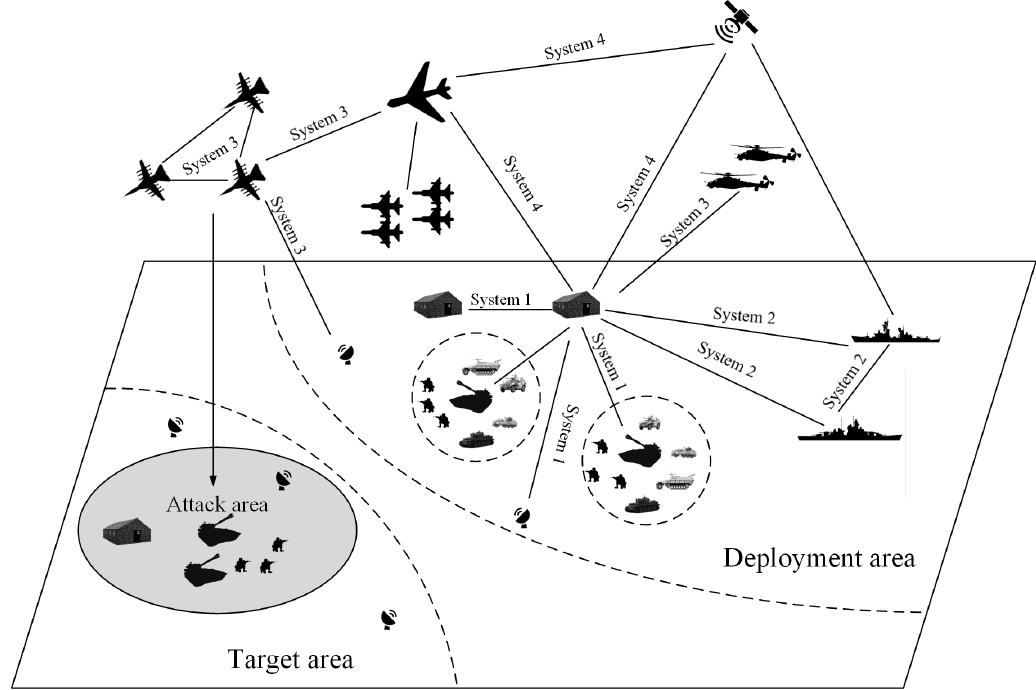
Figure 1. Multiple combat units with different information systems in the battlefield